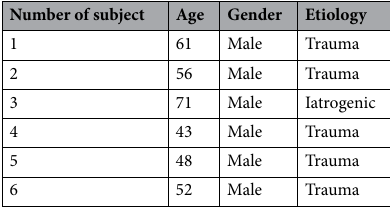
Table 1. Patient demographics in this